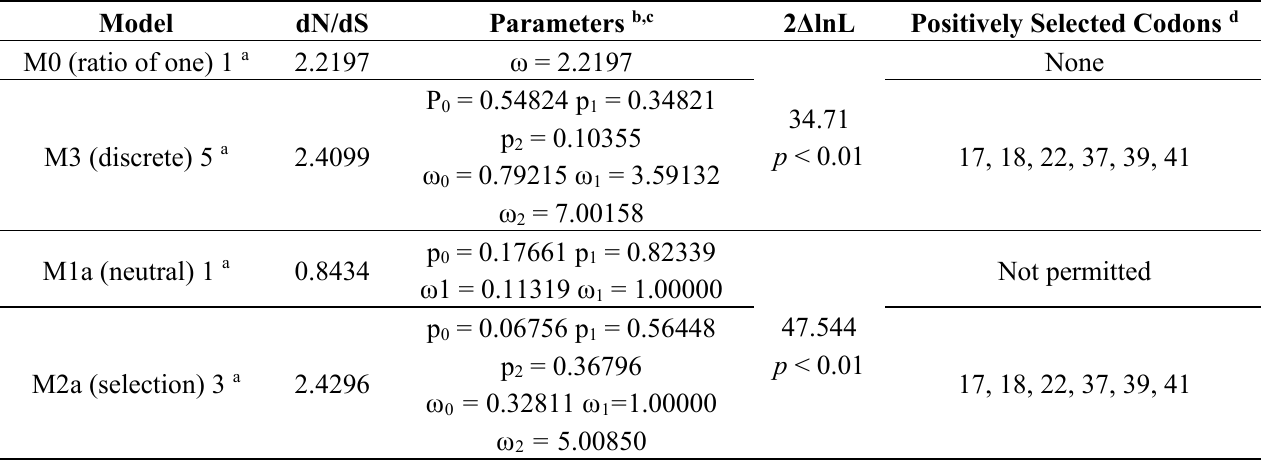
Table 2. Summary of the parameter estimates of different codon evolution models for the EIAV S2 gene. dN: non-synonymous; dS: